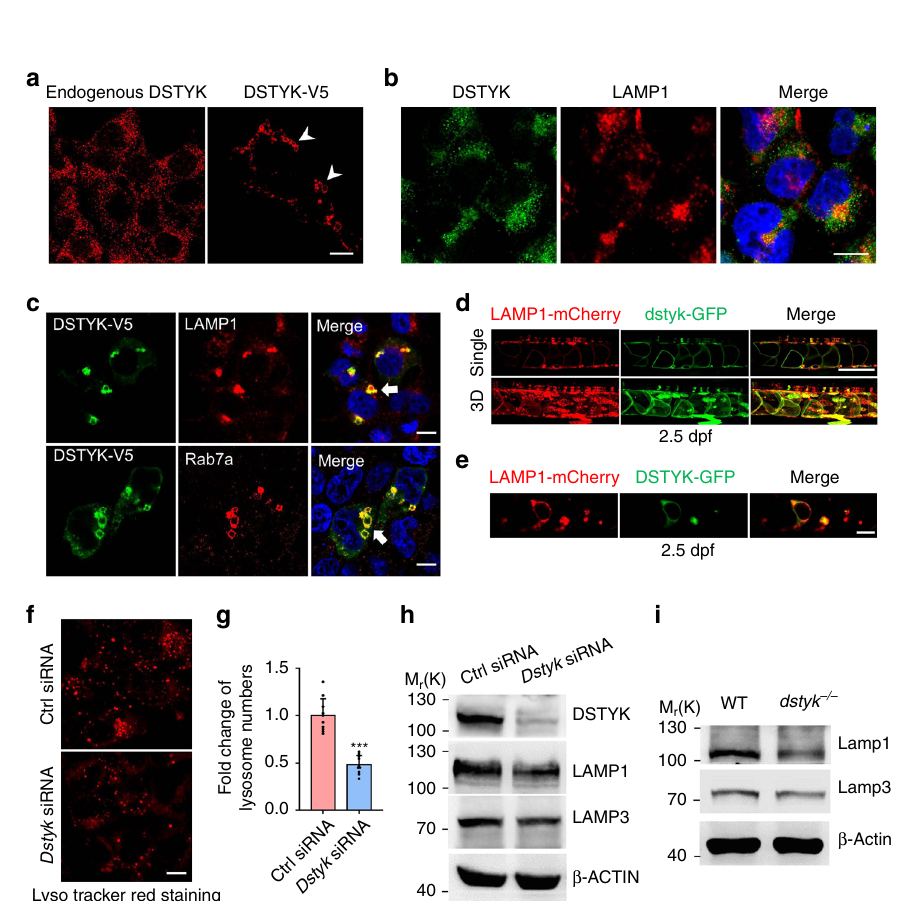
Fig. 8 DSTYK is involved in lysosome biogenesis. a Representative images of immuno fl uorescent staining for endogenous DSTYK (left) and transfected with exogenous DSTYK-V5 (right) in COS-7 cells. White arrowheads indicate large ring-like DSTYK-positive structures. b Double immuno fl uorescent staining of endogenous DSTYK with LAMP1 in COS-7 cells. c COS-7 cells transfected with DSTYK-V5 and double immuno fl uorescent staining of V5 with LAMP1 (top) and Rab7a (bottom). White arrows indicate large ring-like structures co-localization of DSTYK-V5 with LAMP1 and Rab7a. d Confocal images show the 2.5 dpf mosaic transgenic fi shes expressing dstyk-GFP and LAMP1-mCherry (Tg(hsp70l:dstyk-GFP) ; Tg(hsp70l:LAMP1-mCherry)) . Top panel show the single layer and bottom panel showed the 3D view. e Confocal images show the single layer of 2.5 dpf mosaic transgenic fi shes expressing DSTYK-GFP and LAMP1-mCherry (Tg(hsp70l:DSTYK-GFP) ; Tg(hsp70l:LAMP1-mCherry)) . Heat shocking at 72 hpf and imaging at about 78 hpf. f Representative images of LysoTracker Red staining of lysosome after transfected with control siRNA (top) and Dstyk siRNA (bottom) in COS-7 cells. g Quanti fi cations of lysosome numbers after transfected with control siRNA or Dstyk siRNA. n = 10 independent views from three independent experiments, fi ve cells were counted for each view. *** p < 0.001. p values were determined by unpaired two-tailed Student ’ s t -test. h Immunoblotting of LAMP1 and LAMP3 in COS-7 cells transfected with control siRNA and Dstyk siRNA. i Immunoblotting of Lamp1 and Lamp3 in WT and dstyk mutant zebra fi sh. Data are presented as mean ± SD. Scale bar represent 10 μ m in ( a – c ), and ( f ), 100 μ m in ( d , e ). Source data are provided as a Source Data fi